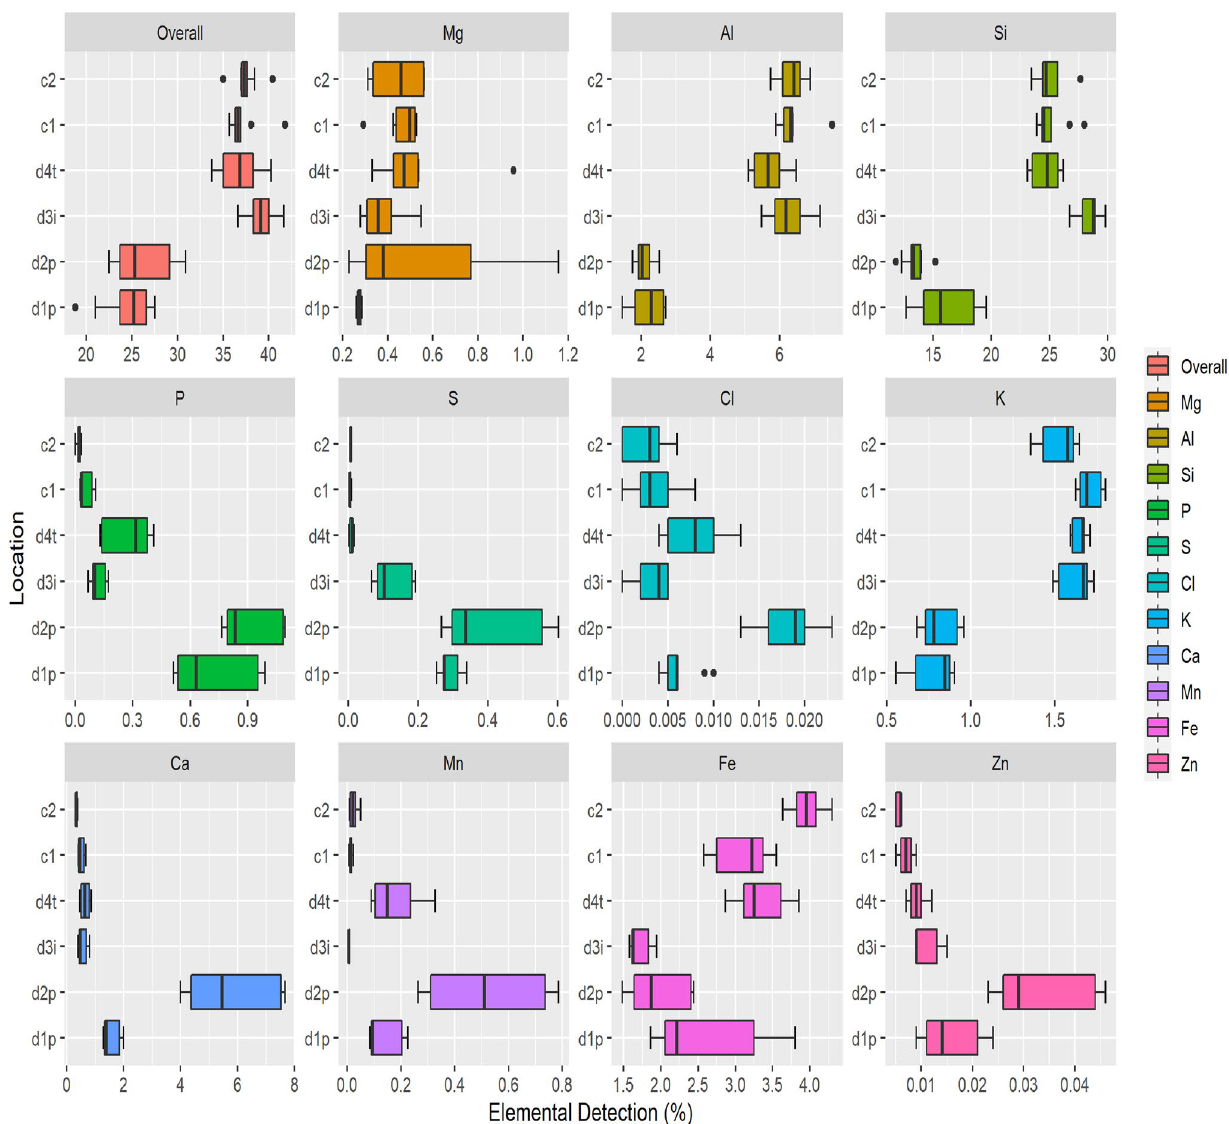
Figure 1. Elemental analysis for minor and major elements from sample d1p, d2p, d3i, d4t, c1 and